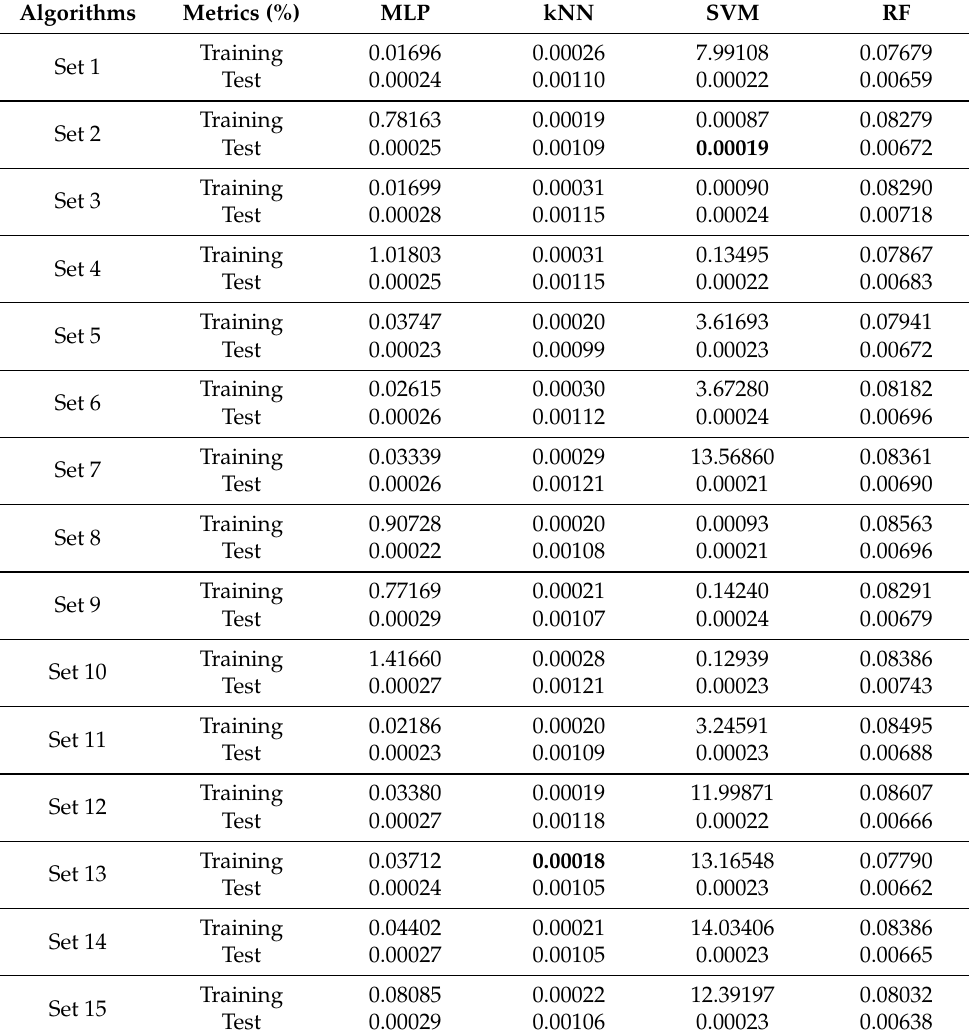
Table 6. Training and testing times of the chosen algorithms on the ankle MRI